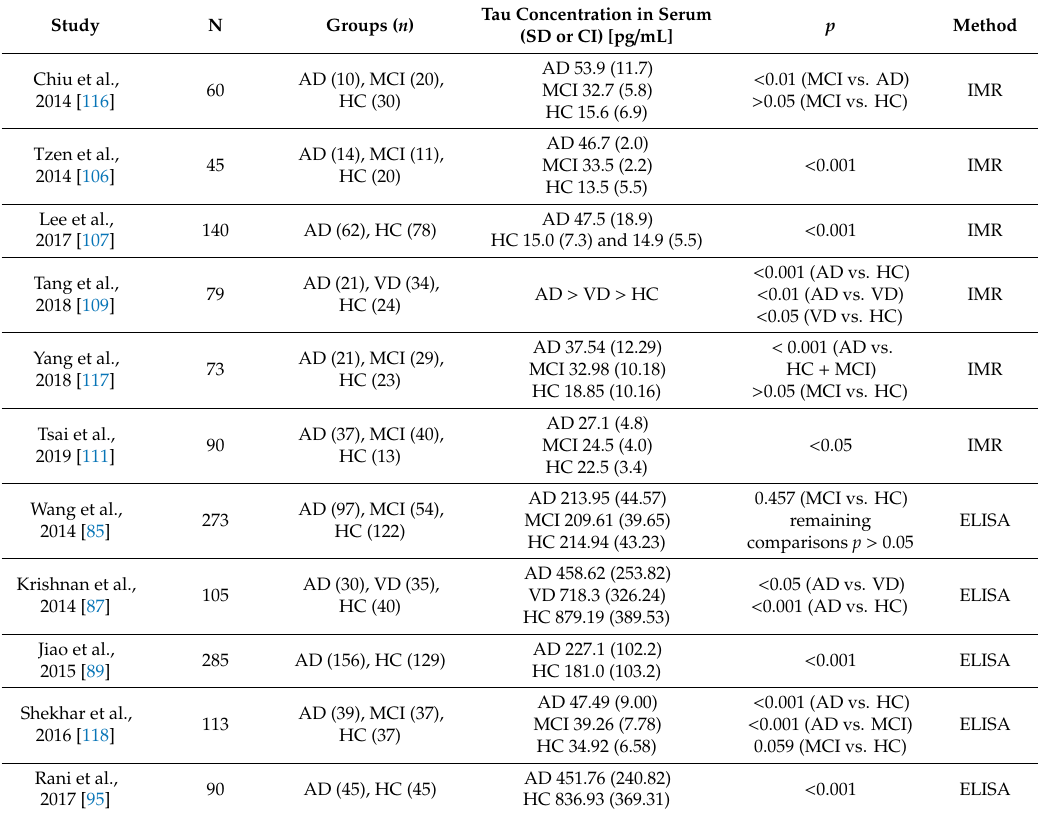
Table 3. Studies on t-tau concentration in